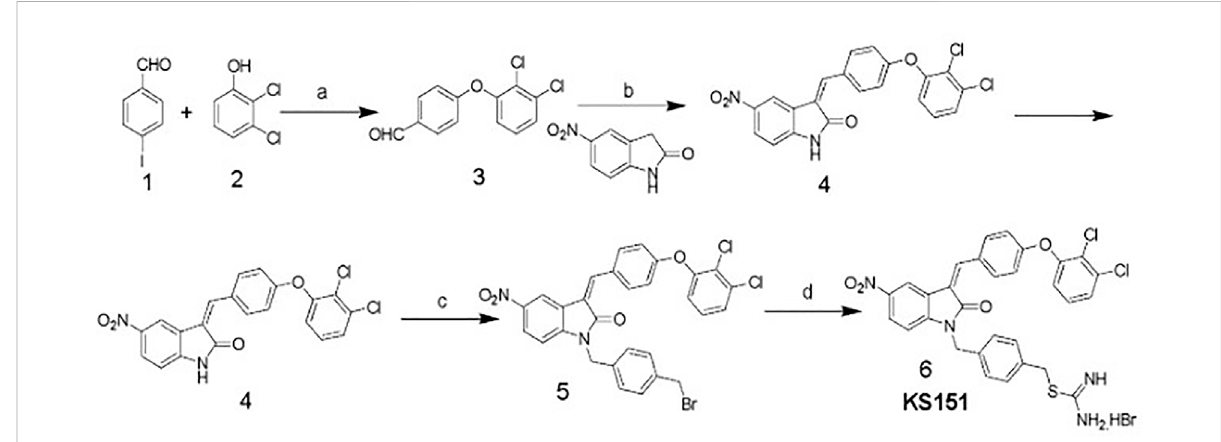
FIGURE 2 Scheme of KS151 synthesis and conditions: a) Cs 2 CO 3 , Cul, N,N-dimethylglycine, dioxane; b) EtOH, pipiridine, re fl ux, 8 h; c) K 2 CO 3 /DMF, BrCH 2 C 6 H 4 CH 2 Br, 8 h; and d) Thiourea, EtOH, 100 ° C, 4